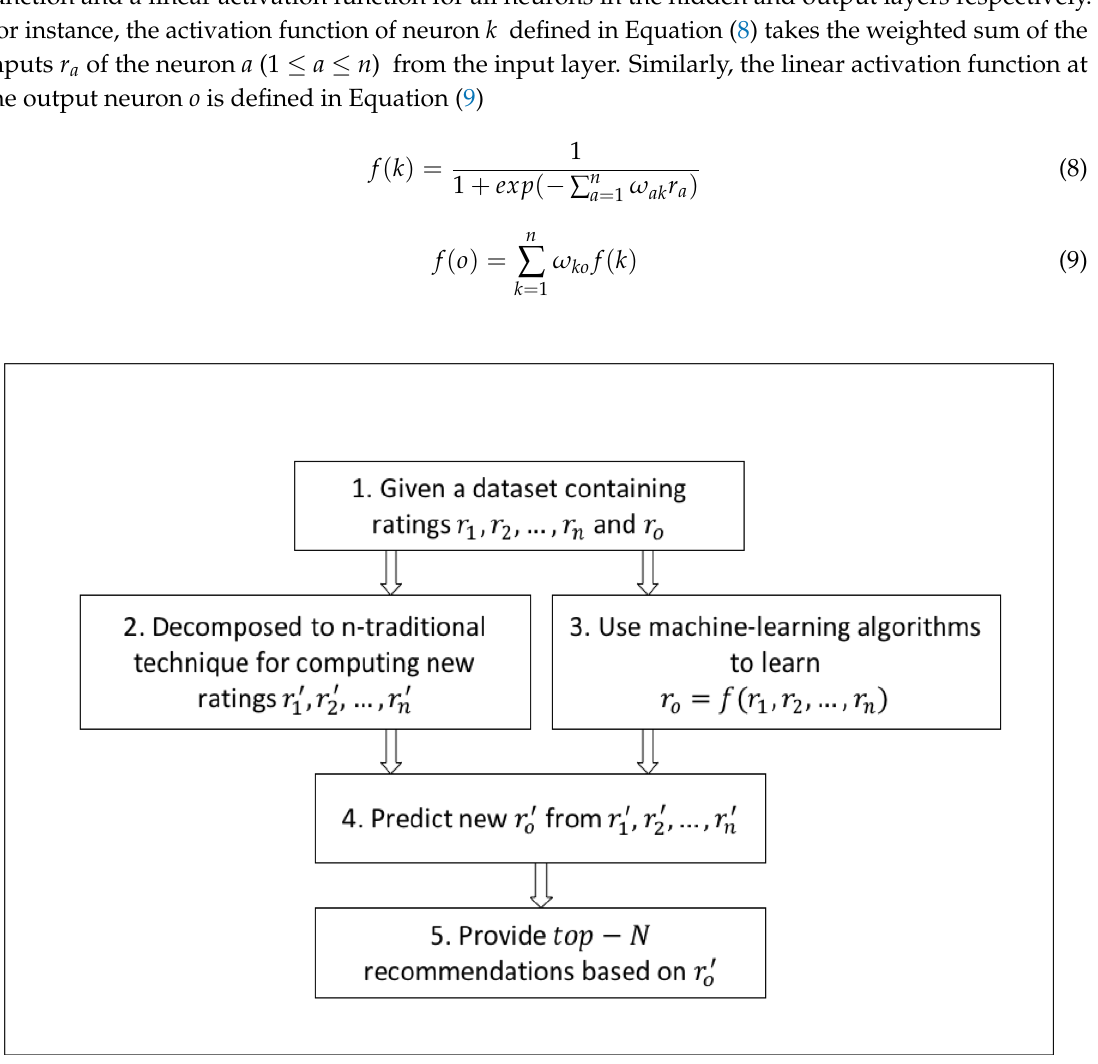
Figure 1. General framework of aggregation function-based MCRSs